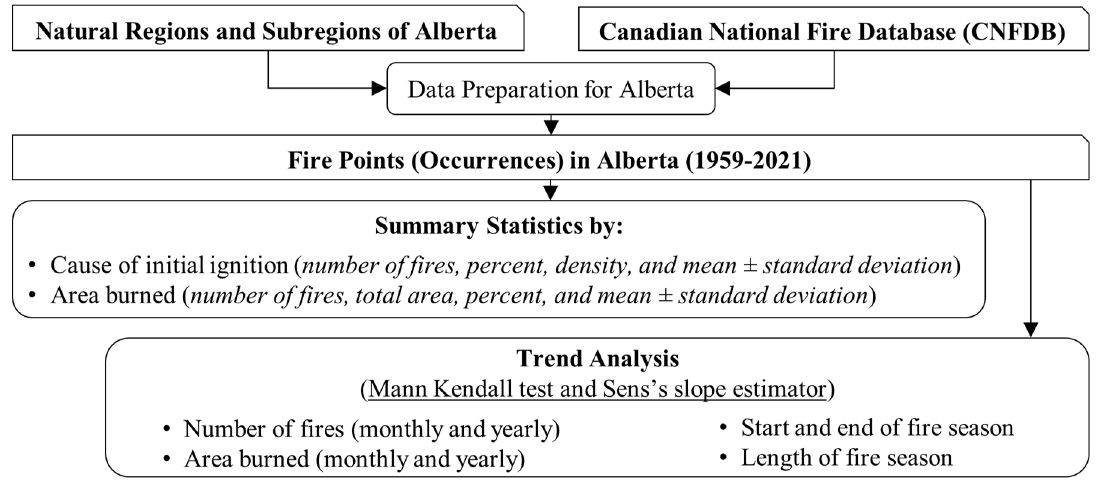
Figure 2. A schematic diagram of the methods of the study.